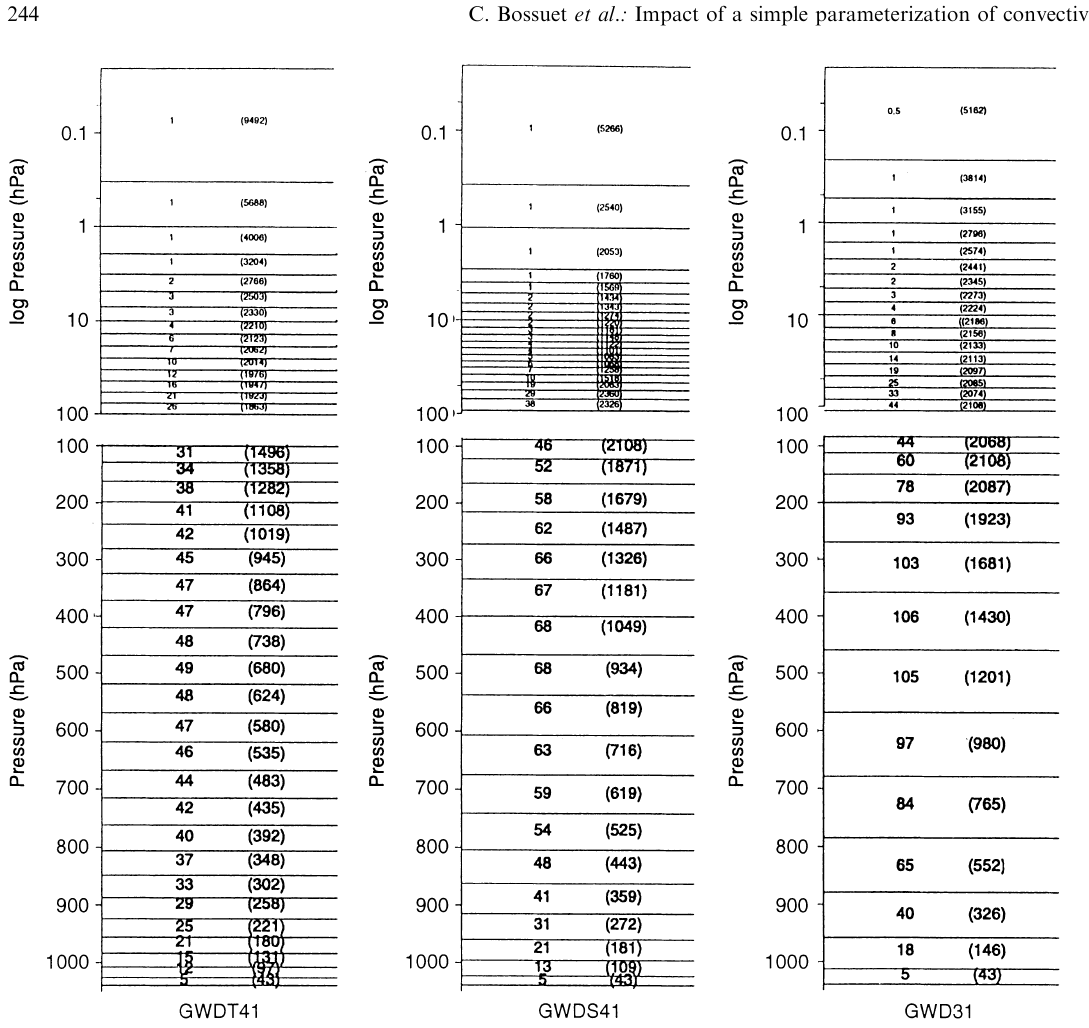
thicknesses shown for each layer (without parentheses) are in hPa and assume a surface value of 1000 hPa. Approximate height thicknesses in metres are shown for each layer